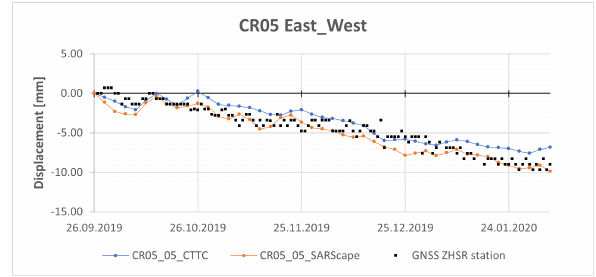
Figure 12. The CR5 horizontal displacements determined by PSI and GNSS measurements